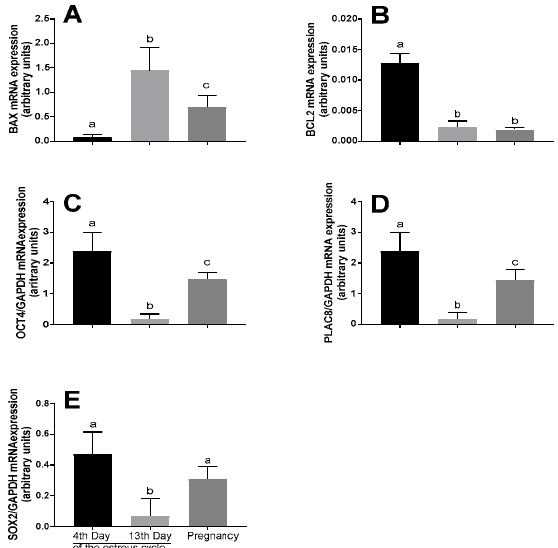
Figure 2. mRNA expression of BAX ( A ), BCL2 ( B ), OCT4 ( C ), PLAC8 ( D ), and SOX2 ( E ) in red deer blastocysts received on the 4th day versus the 13th day of the estrous cycle versus during pregnancy, as determined by real-time PCR. Data were normalized against the mRNA expression of the internal control gene glyceraldehyde-3-phosphate dehydrogenase ( GAPDH ). Bars represent the mean ± SEM. Di ff erent letters (a, b, c) indicate statistically significant di ff erences. p < 0.05 was considered